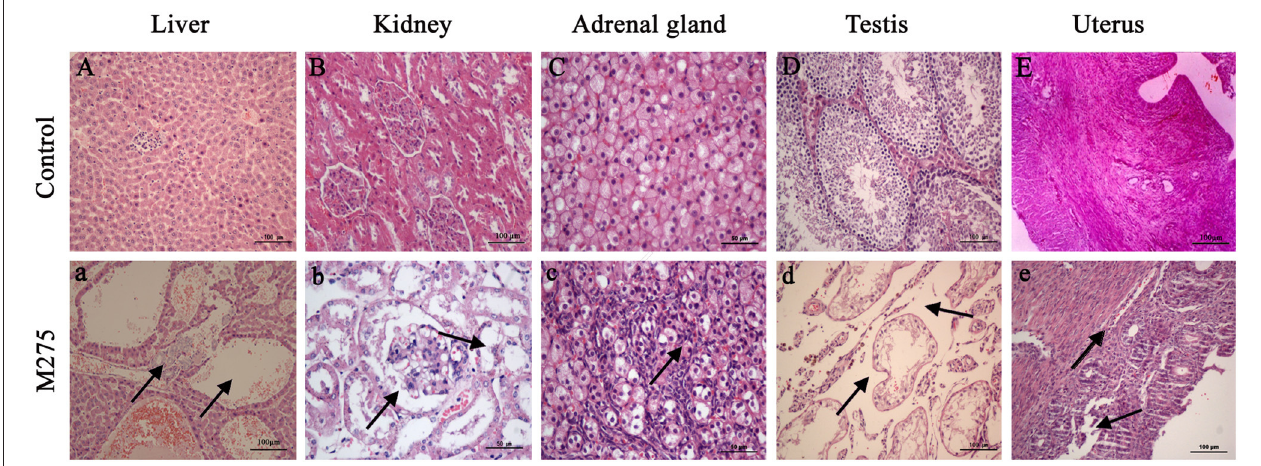
FIGURE 4 | Selected microphotographs of liver, kidney, adrenal gland, testis and uterus (200X and 400X). M275, 275 mg/kg diet. (A) Liver (200X), (B) kidney (200X), (C) adrenal (400X), (D) testis (200X), and (E) uterus (200X) of F 0 and F 1 from the control group; (a) Liver in the 275 mg/kg MEQ group (200X). The vacuoles with a large number of blood cells, and hyperplasia of the epithelioid cells of the bile duct were marked with arrows; (b) Kidney in the 275 mg/kg MEQ group (400X). The swelling and hyperplasia of renal vesicle wall cell, and degeneration and necrosis of renal tubular epithelium were marked with arrows; (c) Adrenal gland in the 275 mg/kg MEQ group (400X). The proliferation of fascicular zone cell, increased binuclear cell and adrenocortical tumor were marked with arrows; (d) Testis in the 275 mg/kg MEQ group (200X). The broadening of interstitial, necrosis and dissolution of spermatogonial cells and spermatocytes in the lumen were marked with arrows; (e) Uterus in the 275 mg/kg MEQ group (200X). The incomplete structure and neutrophil infiltration in submucosal glands were marked with